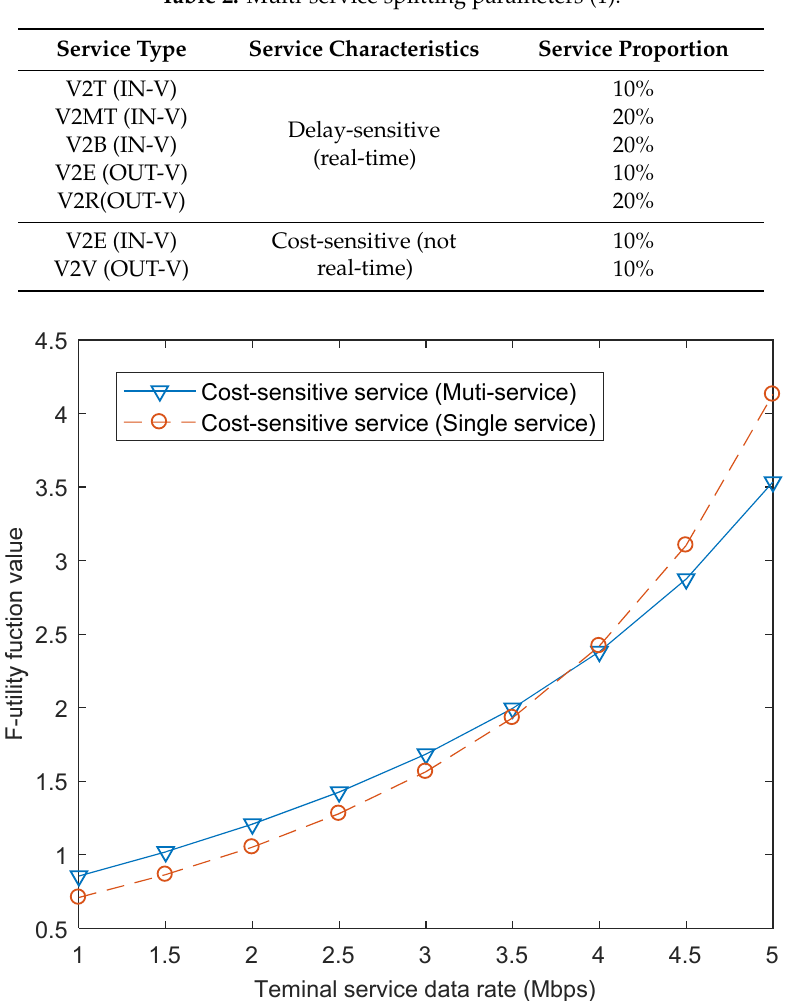
Table 2. Multi-service splitting parameters (1).